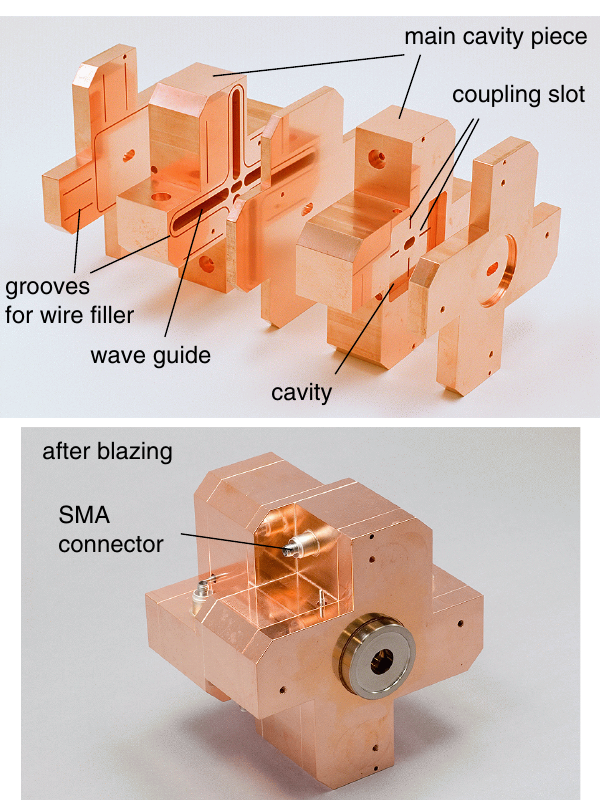
FIG. 5. (Color) Fabrication of the BPM block. A BPM block, which contains two cavities, is made by stacking 5 copper pieces. The copper pieces and SMA connectors were attached by a brazing process as shown in the bottom figure (ICF flanges are not yet attached in this